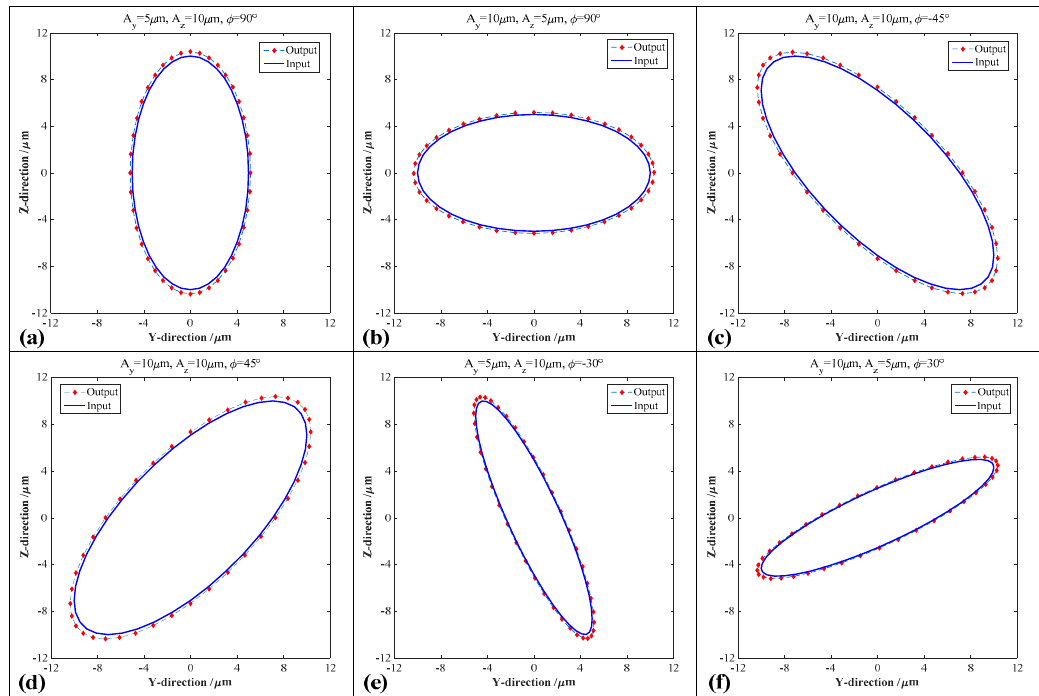
Figure 6. Comparative analysis of the elliptical trajectories generated by the 2-DOF PDCM under different elliptical parameters. ( a ) A y = 5 μ m, A z = 10 μ m, φ = 90°; ( b ) A y = 10 μ m, A z = 5 μ m, φ = 90°; ( c )